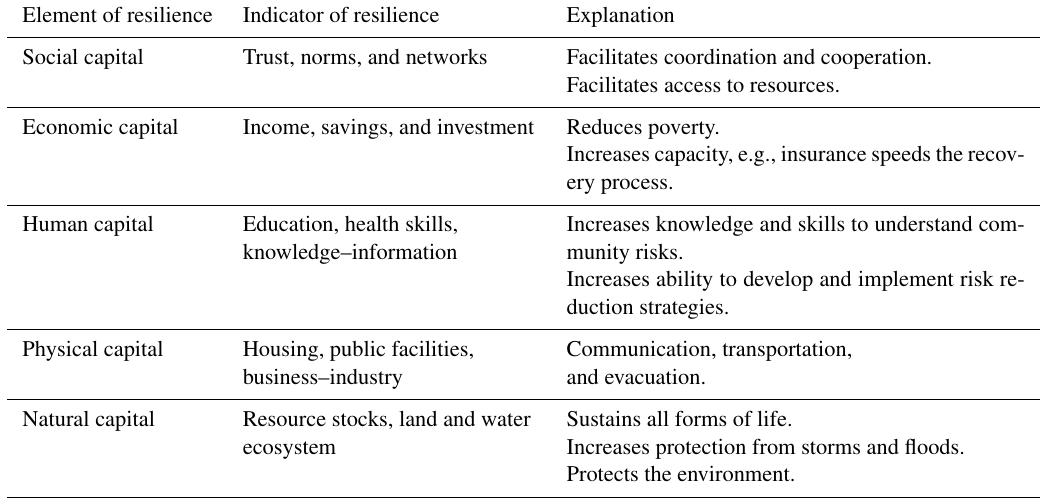
Table 5. Framework for evaluating resilience (Mayunga, 2007). Element of resilience Indicator of resilience Explanation Social capital Trust, norms, and networks Facilitates coordination and cooperation. Facilitates access to resources. Economic capital Income, savings, and investment Reduces poverty. Increases capacity, e.g., insurance speeds the recov- ery process. Human capital Education, health skills, Increases knowledge and skills to understand com- knowledge–information munity risks. Increases ability to develop and implement risk re- duction strategies. Physical capital Housing, public facilities, Communication, transportation, business–industry Natural capital Resource stocks, land and water